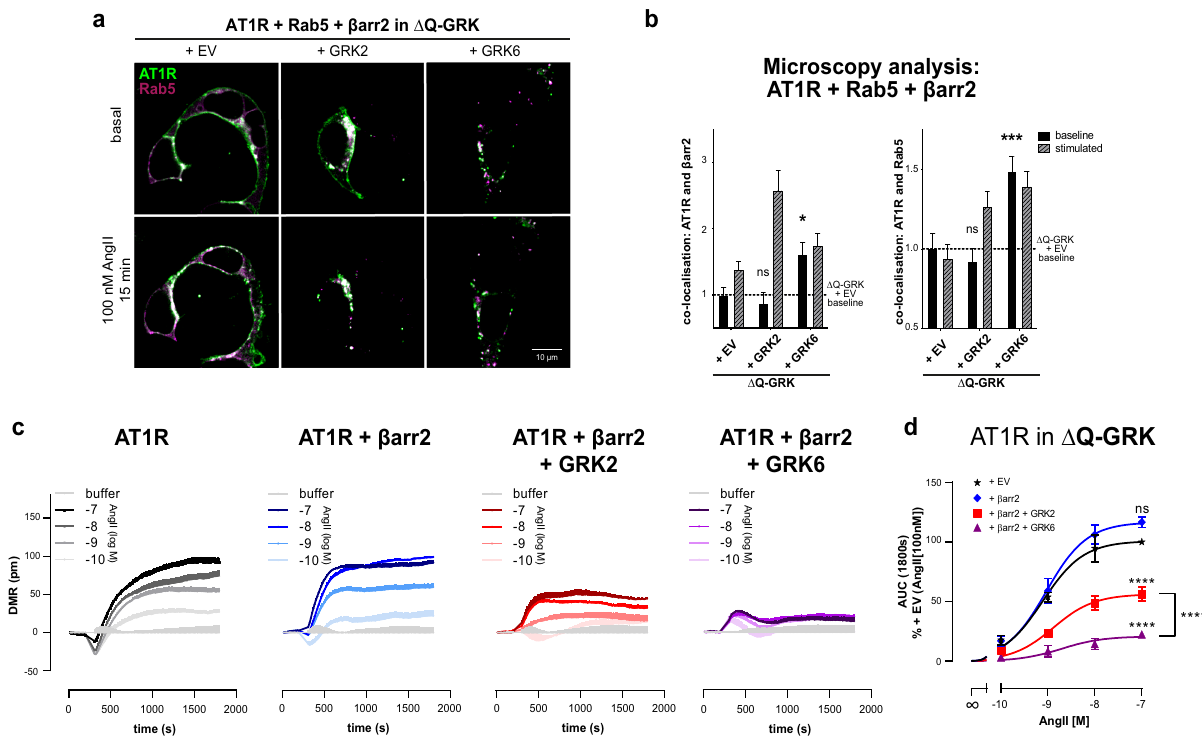
Fig. 6 Pre-coupling of β -arrestin2 mediated by overexpression of GRK6 results in desensitisation and constitutive internalisation of the AT1R. a , b Δ Q-GRK cells were transfected with hsp-AT1R-CFP (green), Rab5-mCherry (magenta), β arr2-YFP (not shown) and either EV, GRK2 or GRK6, as noted. Images were taken before (basal) and after 15 min of 100 nM AngII stimulation. Representative images are shown in ( a ) and Supplementary Fig. 12. The co-localisation of AT1R and β arr2 or Rab5 was quanti fi ed using Squassh and SquasshAnalyst (number of images per respective condition; Δ Q- GRK + EV (31), Δ Q-GRK + GRK2 (31), Δ Q-GRK + GRK6 (33)) ( b ). Data are presented as mean fold change in co-localisation signal + SEM normalised to unstimulated Δ Q-GRK + EV. Co-localisation prior to stimulation was compared using ANOVA and two-sided Dunnett ’ s test (* p < 0.05; ** p <